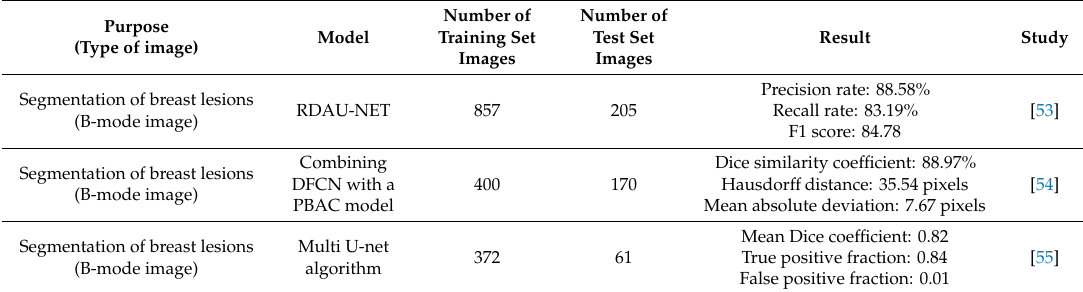
Table 3. Deep learning models for